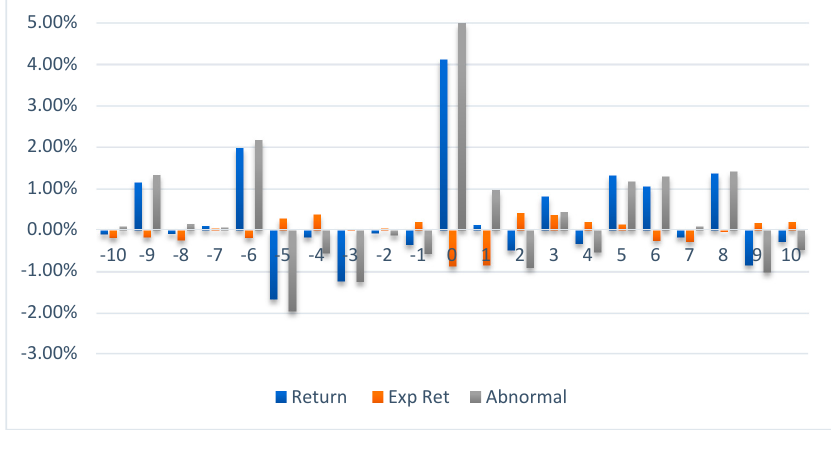
Figure 6. US T-Bond ETF.